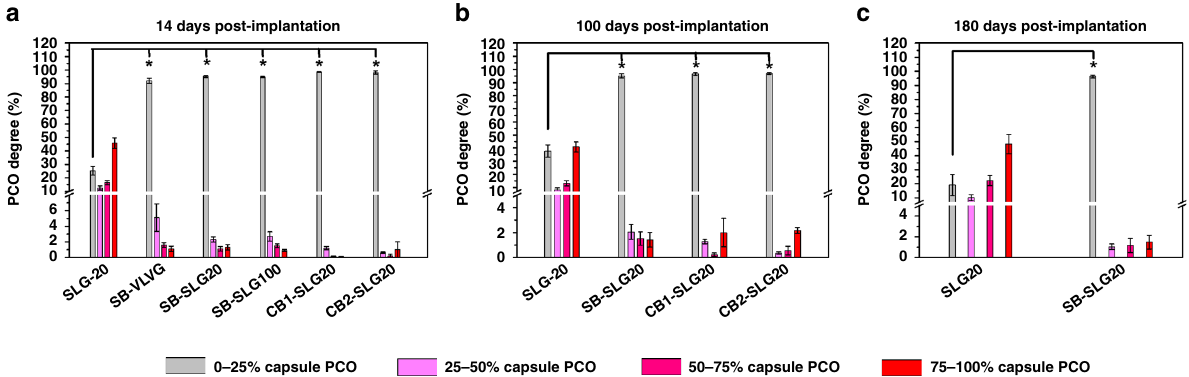
Fig. 3 PCO evaluation of retrieved microcapsules. a Quanti fi cation of PCO for retrieved microcapsules, 14 d post implantation. Mean ± SEM; n = 19 for SLG20; n = 10 for SB-VLVG; n = 16 for SB-SLG20; n = 10 for SB-SLG100; n = 5 for CB1-SLG20; n = 5 for CB2-SLG20. * P < 0.05. b Quanti fi cation of PCO for retrieved microcapsules, 100 d post implantation. Mean ± SEM; n = 12 for SLG20; n = 10 for SB-SLG20; n = 4 for CB1-SLG20; n = 4 for CB2-SLG20. * P < 0.05. c Quanti fi cation of PCO for retrieved microcapsules, 180 d post implantation. Mean± SEM; n = 7 for SLG20; n = 7 for SB-SLG20. * P